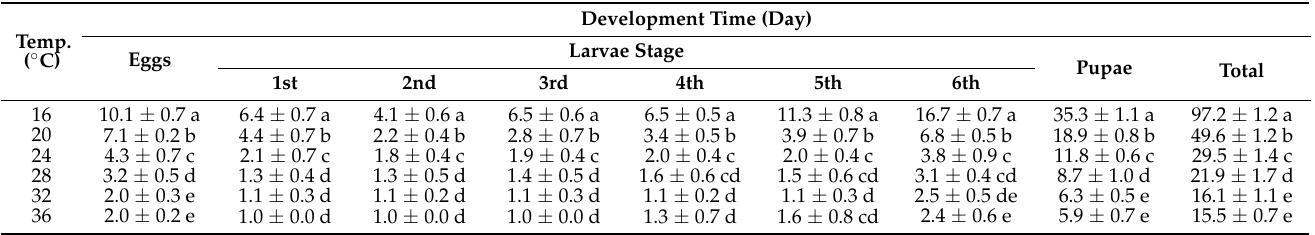
Table 1. Development time (days ± SD) of Spodoptera frugiperda according to temperature (day). Temp. ( ◦ C)